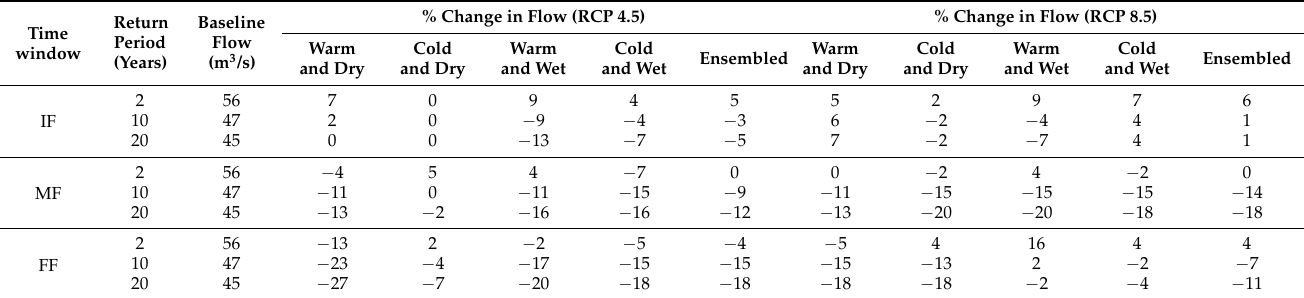
Table 4. One-day-minimum flow frequency